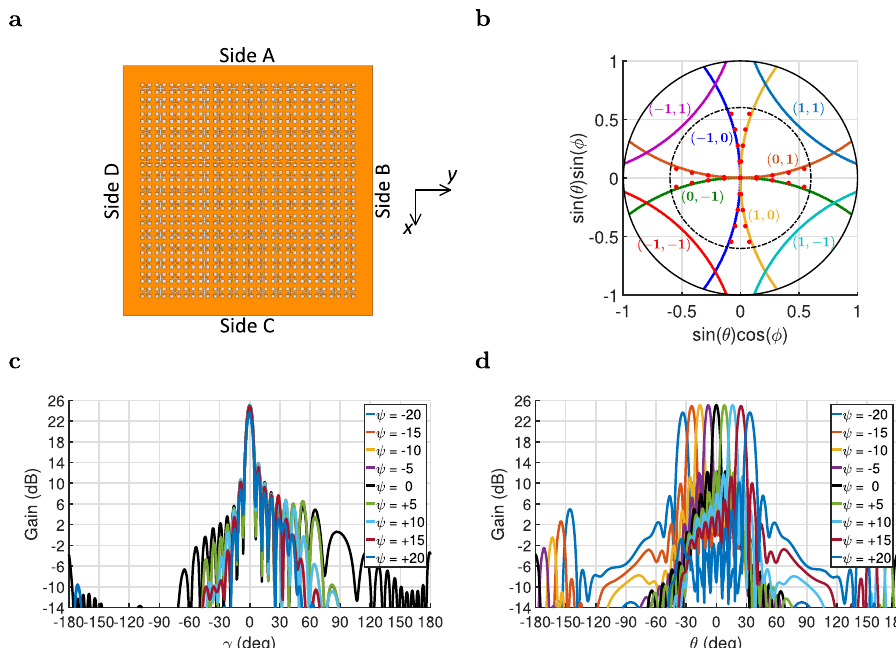
Fig. 3 PEX array simulation. Full-wave simulation of the 15× 15 PEX antenna array: a Top view of the PEX array which is etched on a Rogers RT/duroid 5880 1oz substrate, showing the different sides of the array A, B, C and D, and the coordinate system used. (Dimensions = 245.8mm× 245.8mm× 1.575mm). b Comparison between the analytical (solid) and the full-wave simulated (red dots) pencil-beam directions ( ϕ , θ ) at 13.1 GHz for multiple plane wave directions ( ψ ) exciting the PEX array, both showing a similar scanning behavior along prede fi ned contours with a versatile range of tilted angles. c , d The full- wave simulated realized gain (dB) patterns plotted along the E-plane and H-plane, respectively, at 13.1GHz, for various values of ( ψ ), when only side A is excited. Successful electronic scanning of the generated pencil beams is